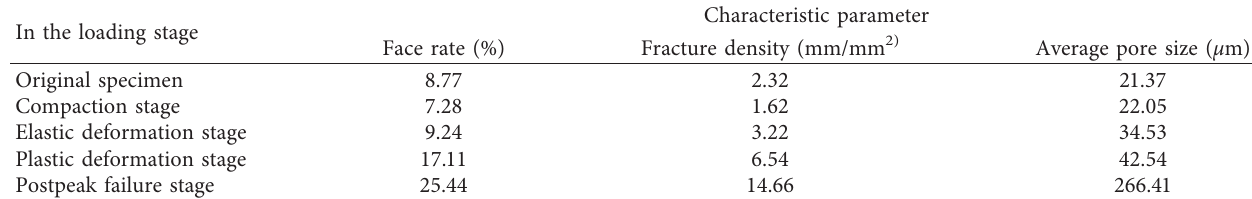
Table 4: Pore characteristic parameters of